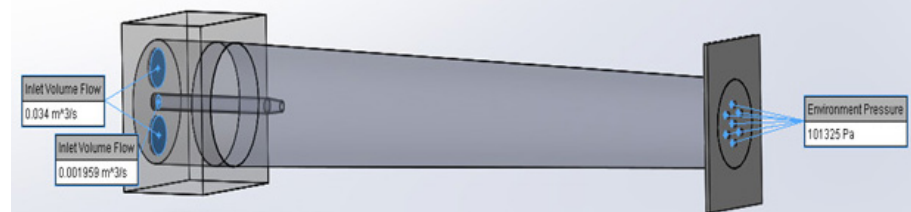
Figure 6. Three-dimensional Solidworks Flow Simulation model of a gas burner with multiple outlet